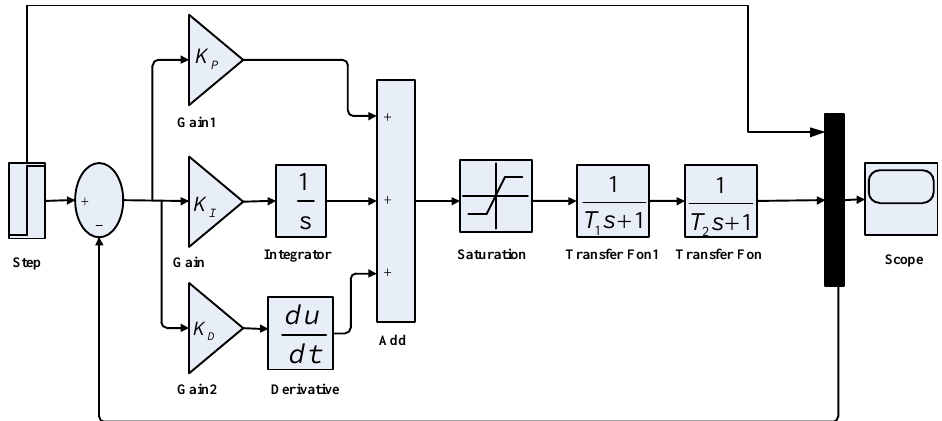
Figure 11. PID regulation simulation model.